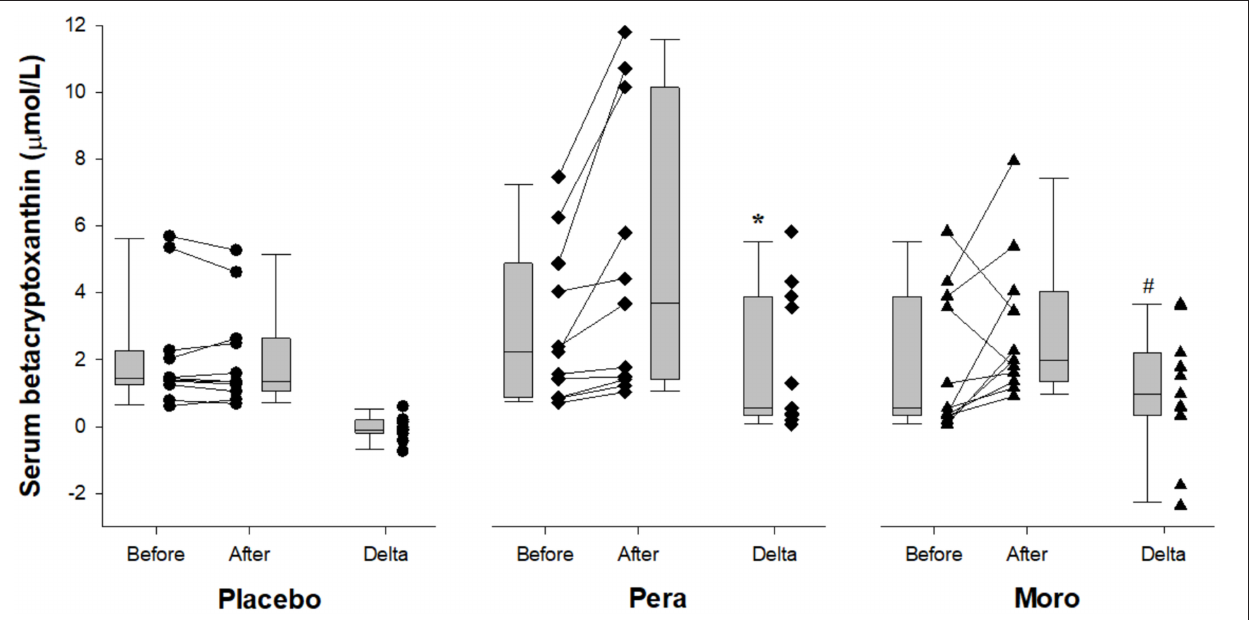
FIGURE 1 | Comparison of serum beta-cryptoxanthin between Placebo, “Pera,” and “Moro” groups ( n = 11 patients per group). The delta values of the three groups were compared using the Kruskal-Wallis test with Tukey’s post-hoc test ( p = 0.005). # Difference between “Moro” and Placebo groups; *difference between “Pera” and Placebo groups.